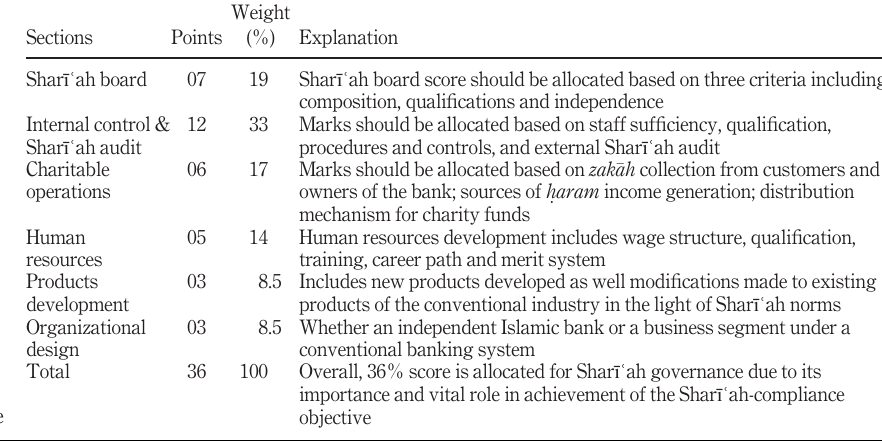
Table V. Shar ī ʿ ah governance